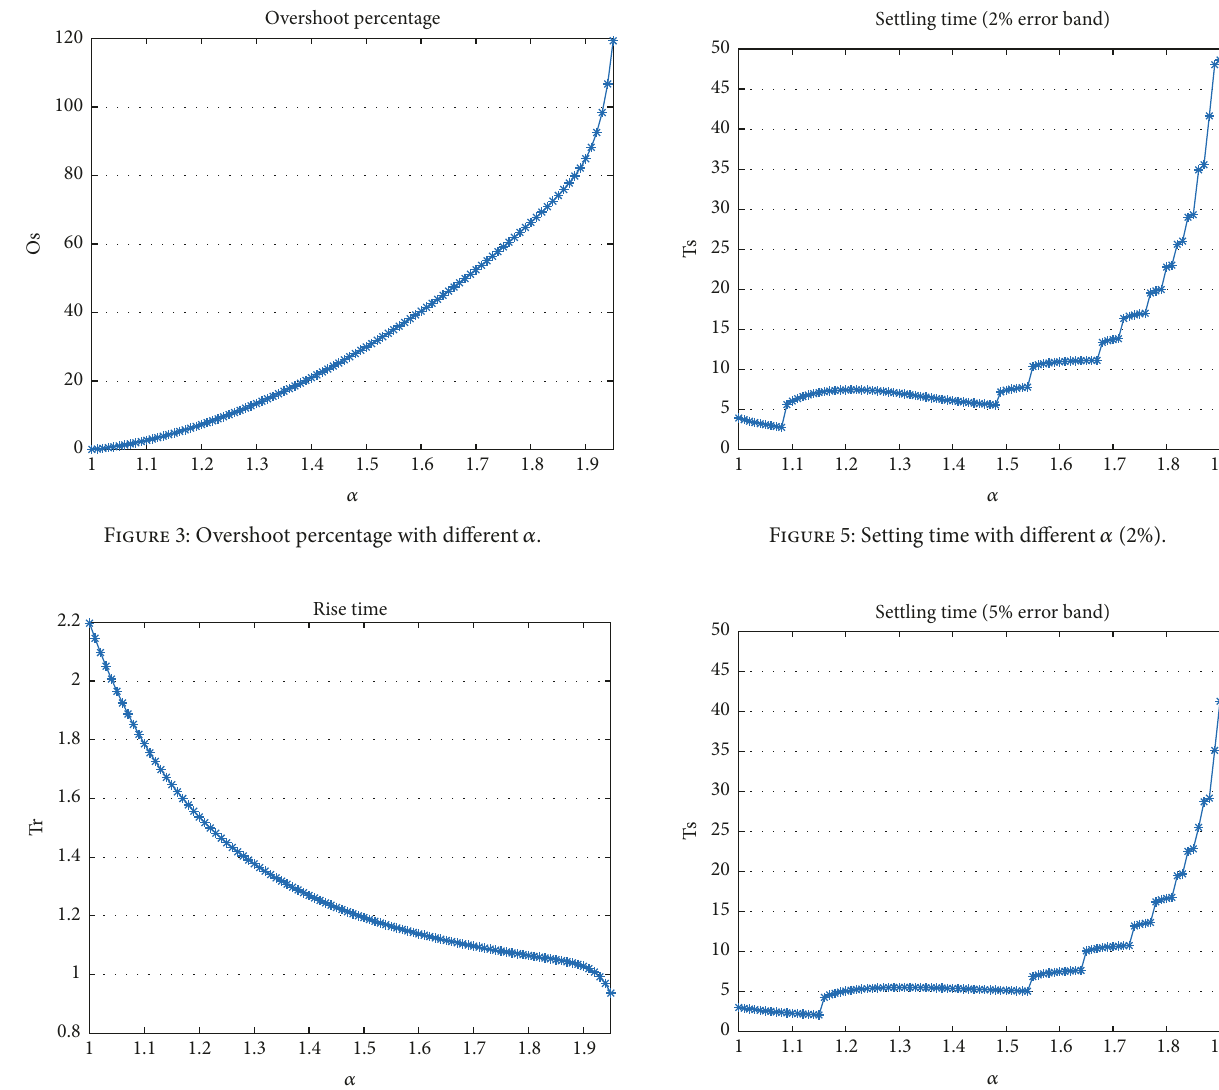
Figure 6: Setting time with different 𝛼